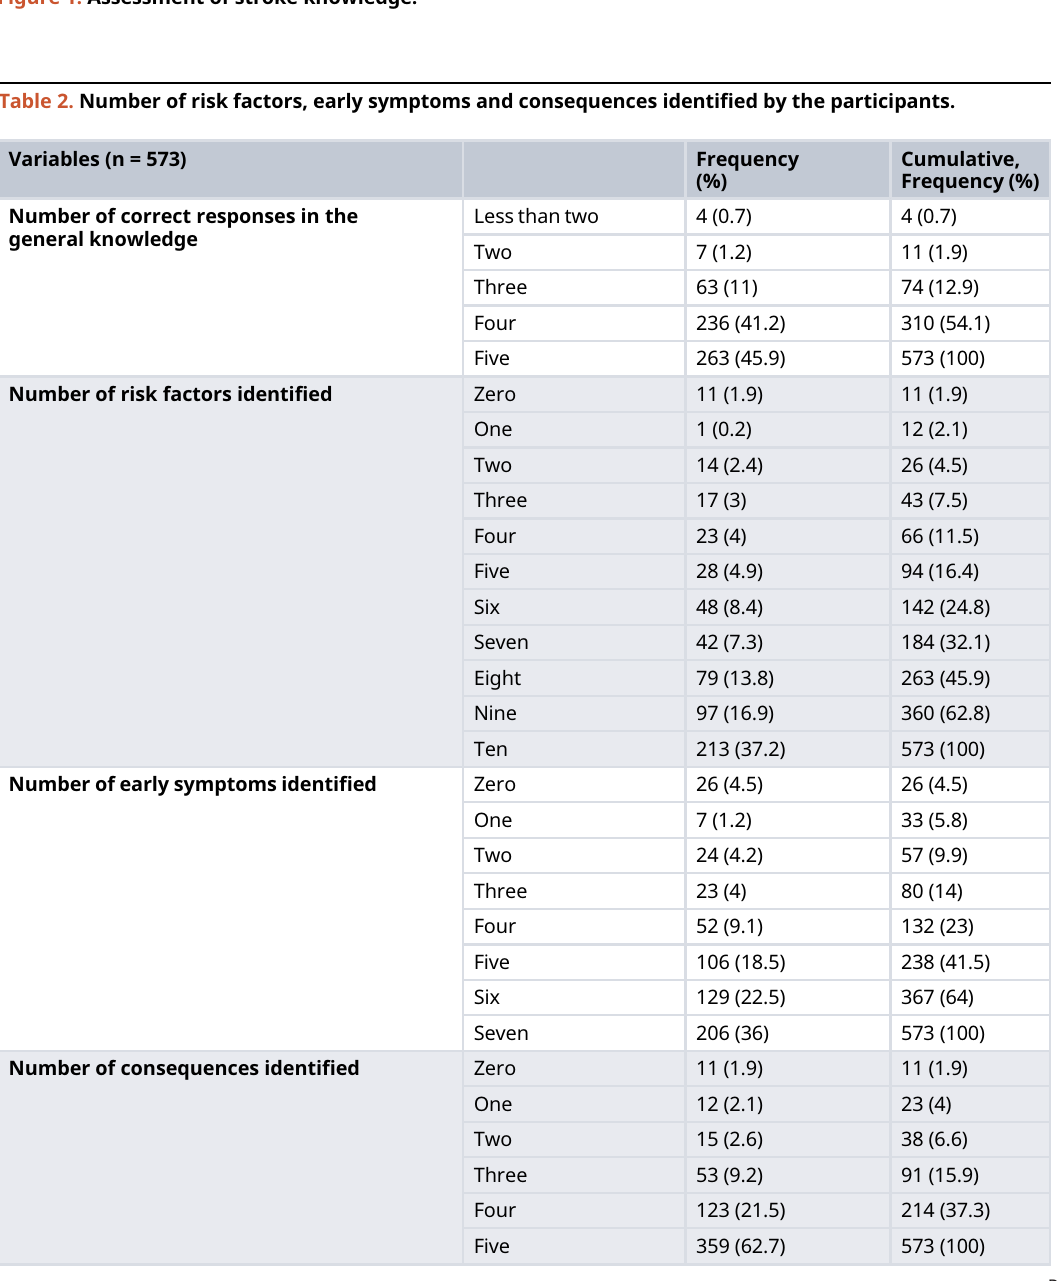
Figure 1. Assessment of stroke knowledge.